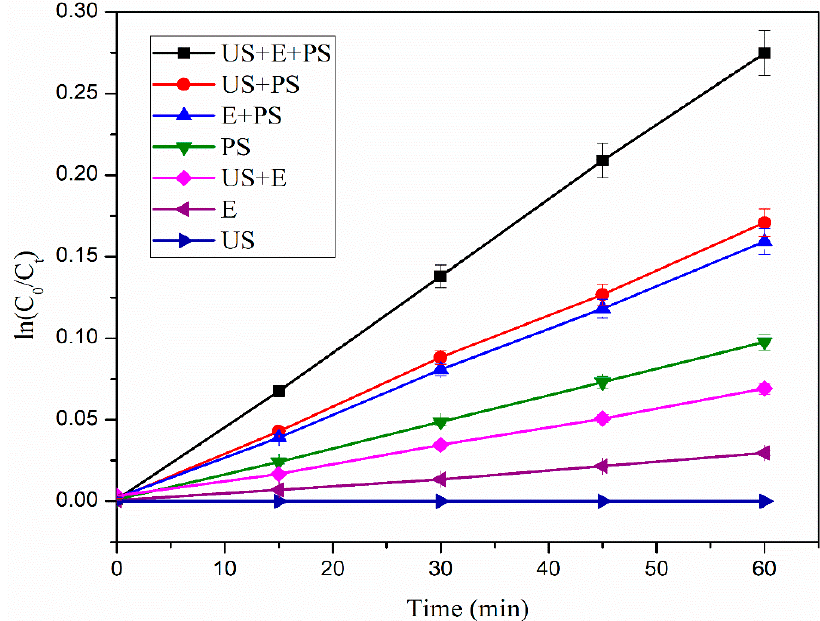
Figure 3. Quasi-first-order kinetics of ciprofloxacin in different reaction systems.